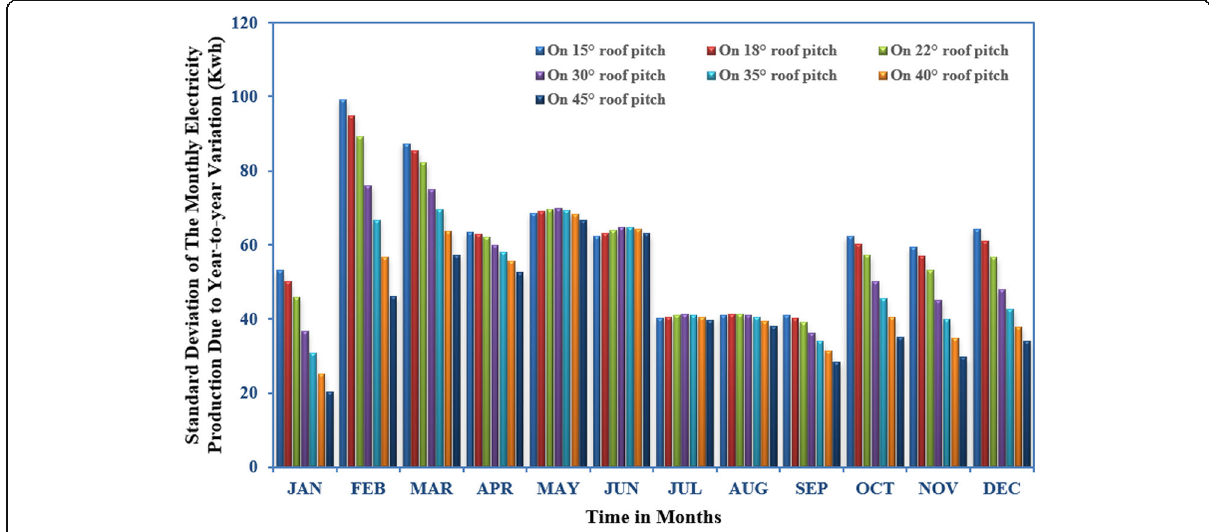
Fig. 7 The standard deviation of monthly electricity production